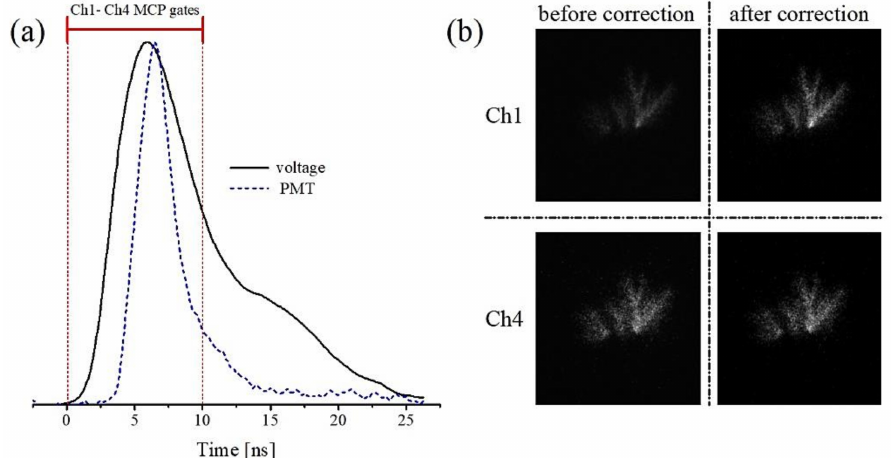
Figure 4. Example of the intensity calibration of the Ch1–Ch4 images through the reference discharge images obtained with equal Ch1–Ch4 MCP gate settings. The anode voltage and PMT waveforms ( a ) illustrate conditions used for acquiring all (calibration and experimental) image sequences. Ch1 and Ch4 images before and after the correction in ( b ) illustrate the calibration results considering Ch4 image as the